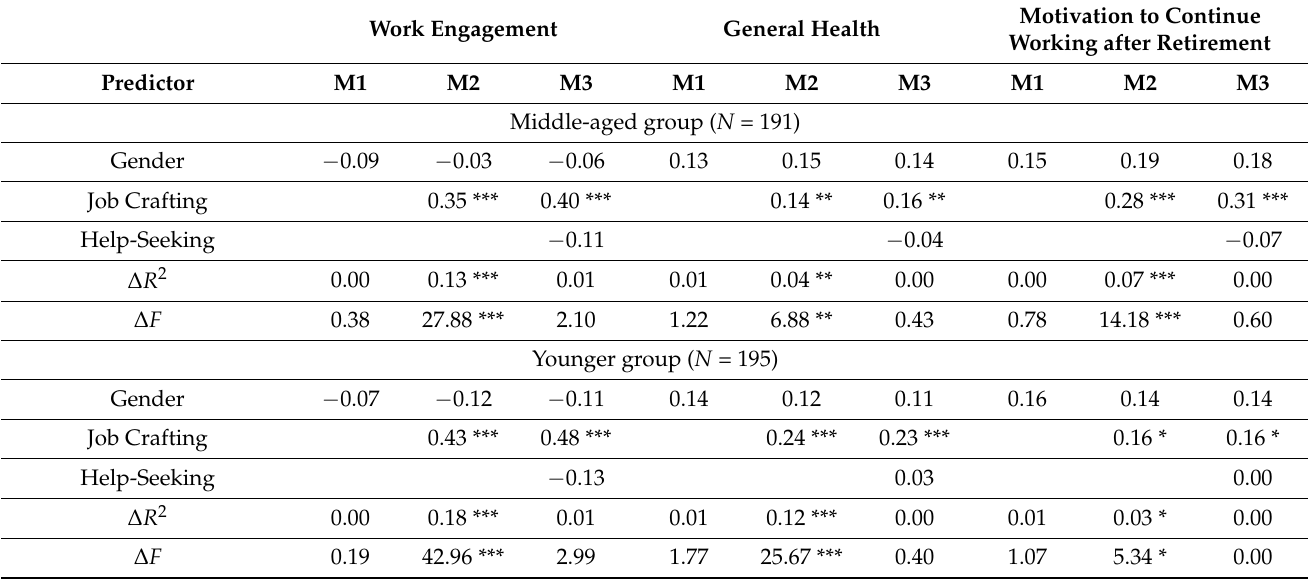
Table 5. Results from hierarchical regression analyses of Help-Seeking predicting healthy ageing at work. Work Engagement General Health